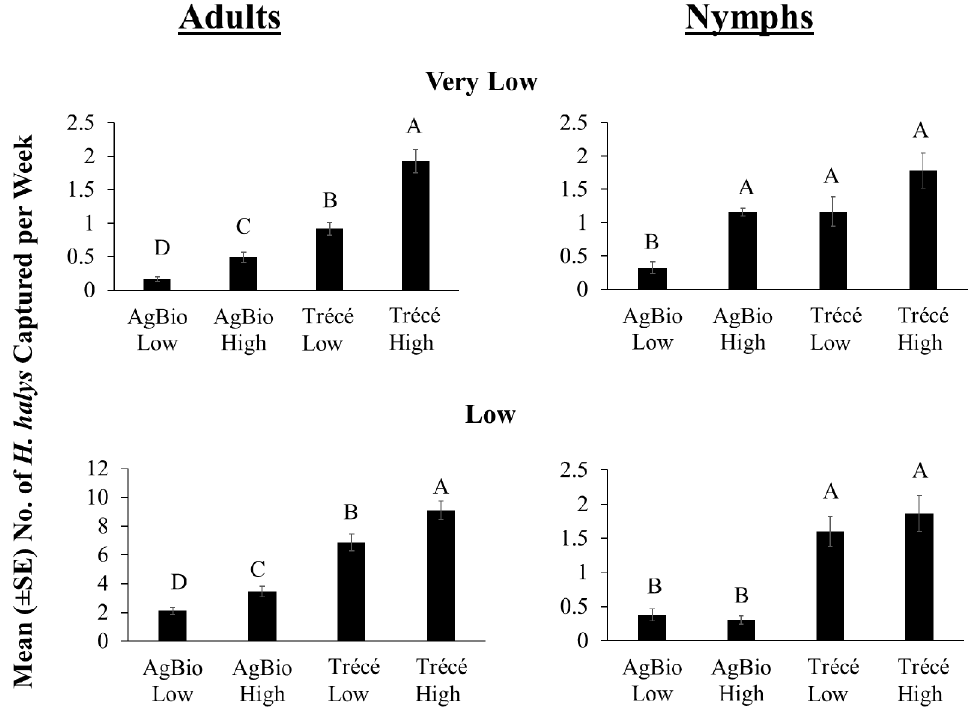
Figure 7. Mean weekly capture of H. halys using different lure types under very low and low relative population densities across six sites in the eastern United States in 2017. Due to differences in the trapping period among the sites, only dates that were common among the sites within each population density were included in the analyses. Data in low and high population sites were obtained from 5 June to 4 September and 22 May to 16 October 2017, respectively. Bars with shared letters are not significantly different from each other at α = 0.05 ( χ 2 mean contrast with Bonferroni correction).